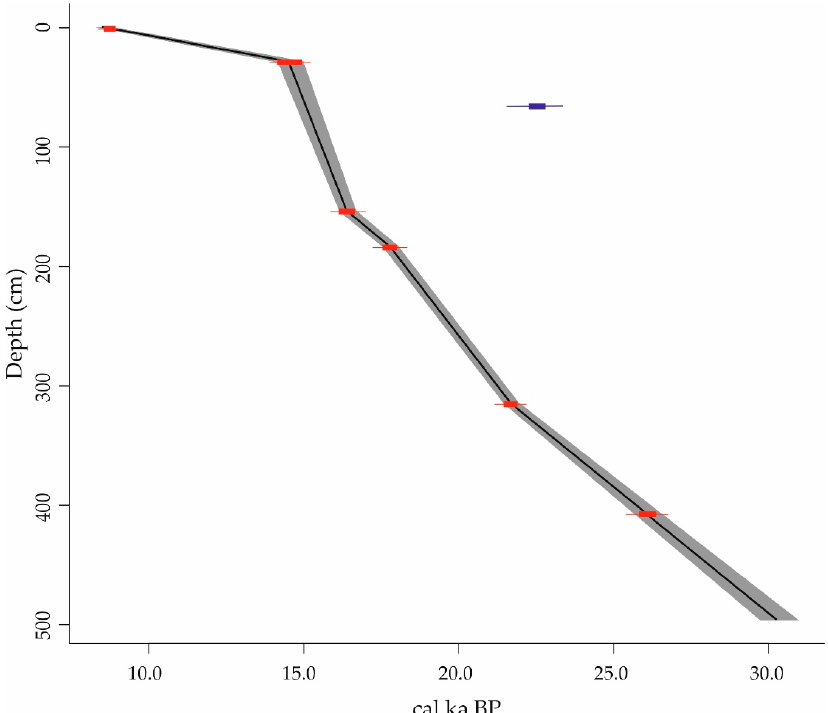
Figure 2. Age-depth model based on linear interpolation of best point calibration age from 14 C dates (in red) obtained using Clam software [47]. The color blue of the age at the depth of 73–75 cm corresponds to the level not included in the age model (see the following text for details). The gray envelope shows the 95% confidence intervals based on 1000 iterations.